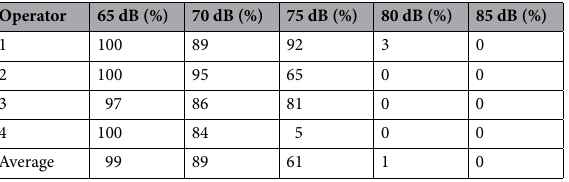
Table 4. Action commands correctly recognized (%) by the Vuzix M400 voice control function at different noise levels (dB) and for different operators.